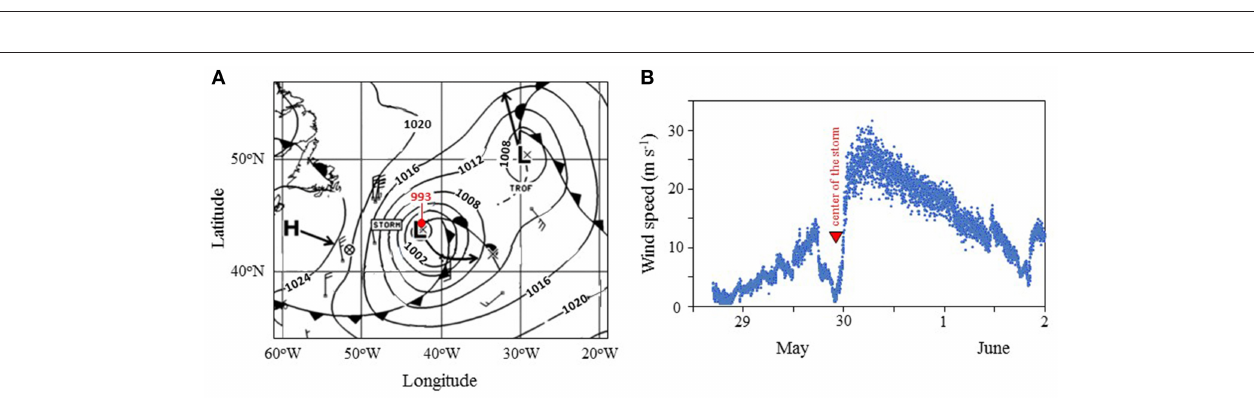
stations were outside of eddies ( Figure 11A ; Table 1 ). Satellite ocean color coverage during NAAMES 3 was the best of all campaigns and indicated low surface chlorophyll concentrations from Stations S1A to S4 and higher concentrations at